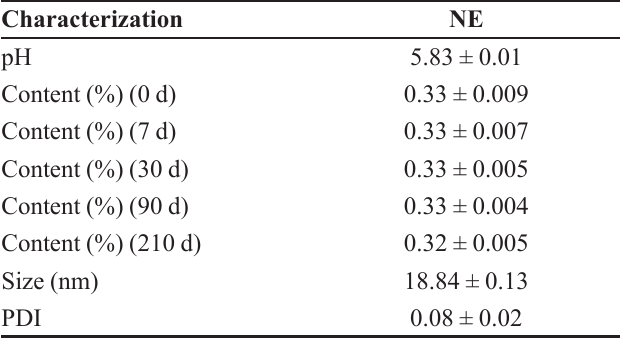
TABLE IV - Results of the organoleptic characteristics, pH, content, size distribution, and polydispersity